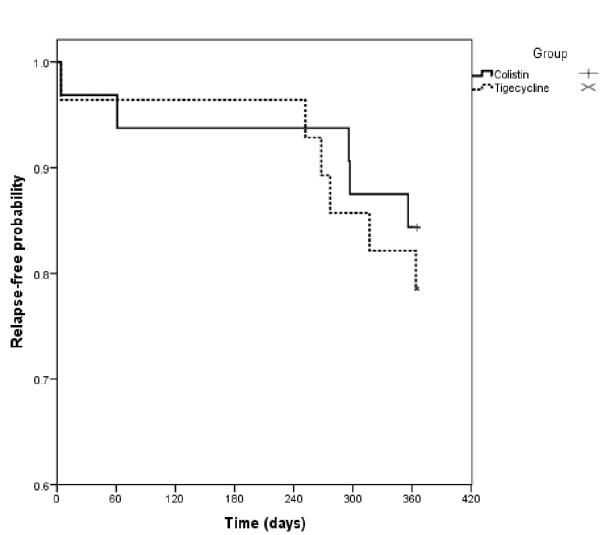
Figure 3. Kaplan-Meier function of recurrence time according to treatment